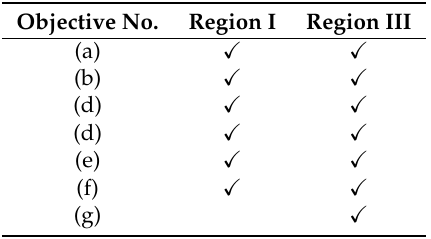
Figure 5. Example of the lifting problem in different regions. Table 2. Objectives for Regions I and